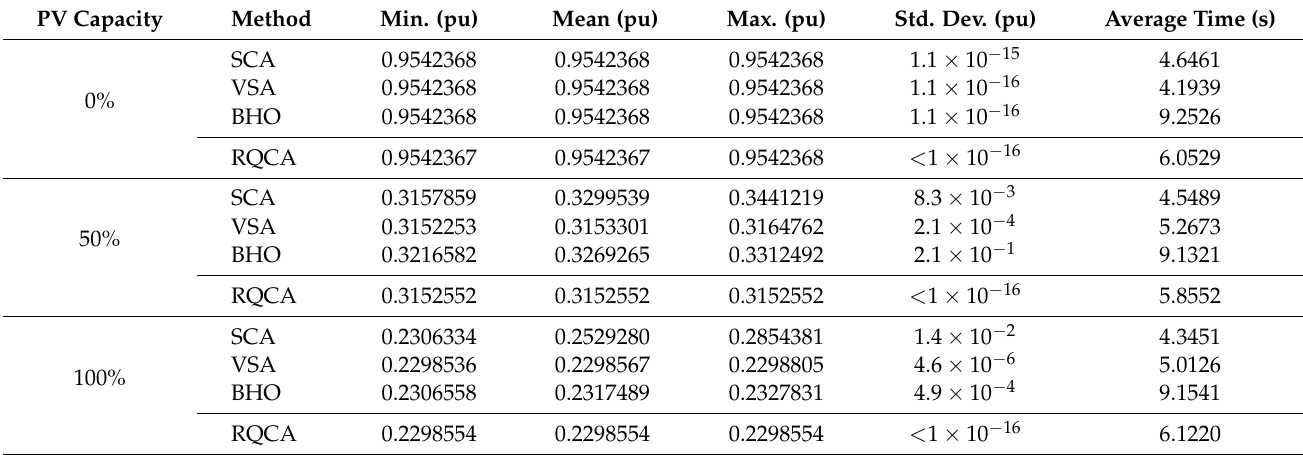
Table 4. Comparison of the models for solving the OPF problem ( P base = 100